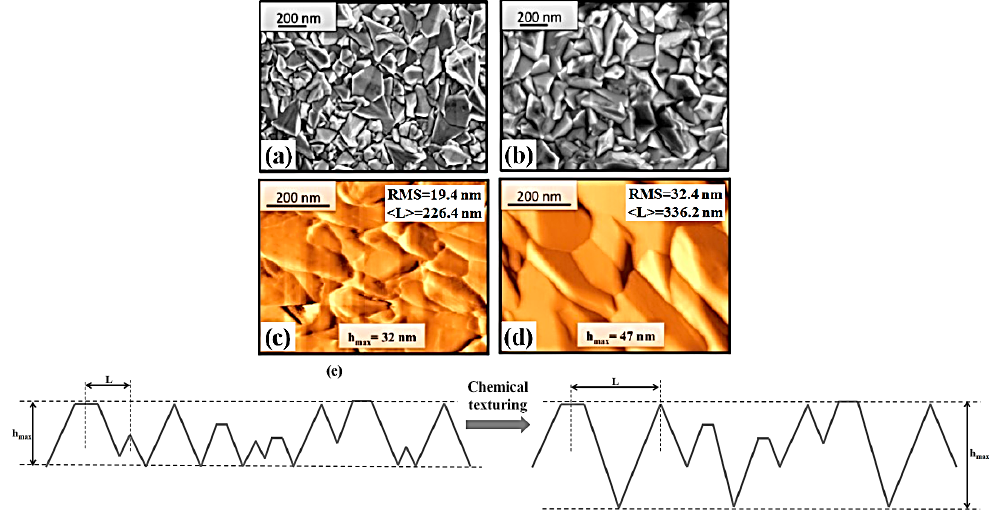
Figure 1. Surface topographic characteristics of the starting FTO susbtrates: ( a ) representative SEM image of the surface of the standard as deposited FTO layer (substrate A); ( b ) representative SEM image of the surface of a as deposited FTO layer after a chemical texturing (substrate B); ( c ) representative AFM image of the surface of the standard as deposited FTO layer with the indication of the RMS value (19.4 nm) as obtained by the AFM analyses and of the mean top-to-top distance < L > between the nearest neighbour pyramids forming the FTO layer (226.4 nm); ( d ) representative AFM image of the surface of the chemically-textured FTO layer with the indication of the RMS value (32.4 nm) as obtained by the AFM analyses and of the mean top-to-top distance < L > between the nearest neighbour pyramids forming the FTO layer (336.2 nm); and ( e ) schematic images of the cross-section morphology of the as-deposited FTO layer (e left) and of the chemically-textured FTO layer (e right) to highlight the effect of the texturing process: it leads to an increase of the surface depth (i.e., increase of the mean height of the pyramids) and to an increase of the mean top-to-top distance between the nearest-neighbour